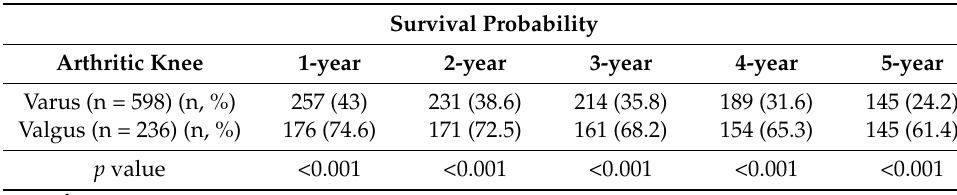
Table 3. Survival probability of varus and valgus arthritic knee. Survival